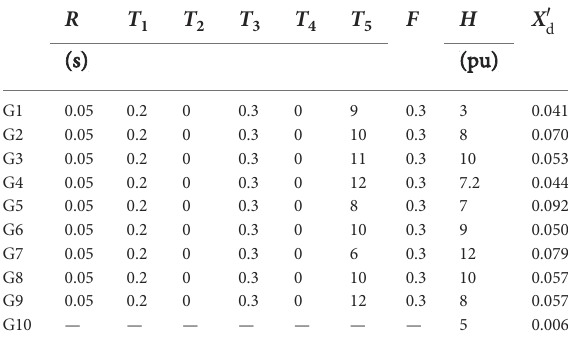
TABLE 3 Parameters of turbine governors and generators for 39-bus system.